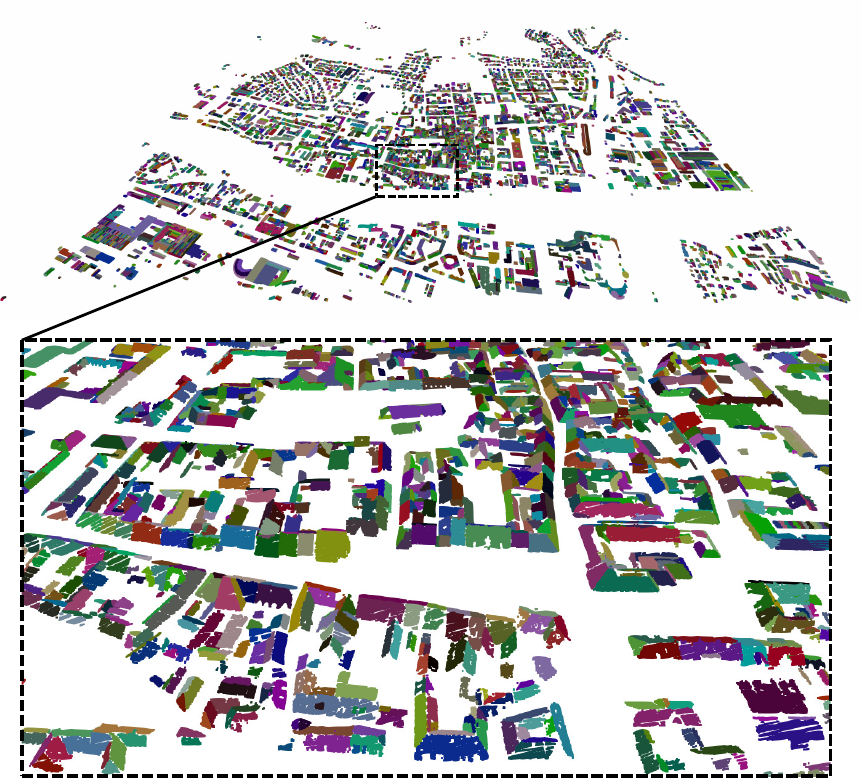
Figure 7. Segmented building points from Figure 6.